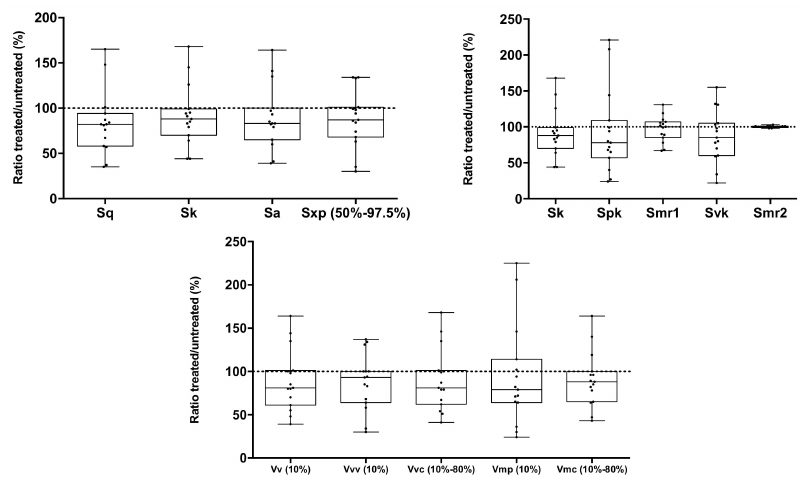
Figure 10. Box-and-whisker charts showing the relationship between the values of 3D parameters (S-parameters) and functional (volume) parameters of treated and untreated